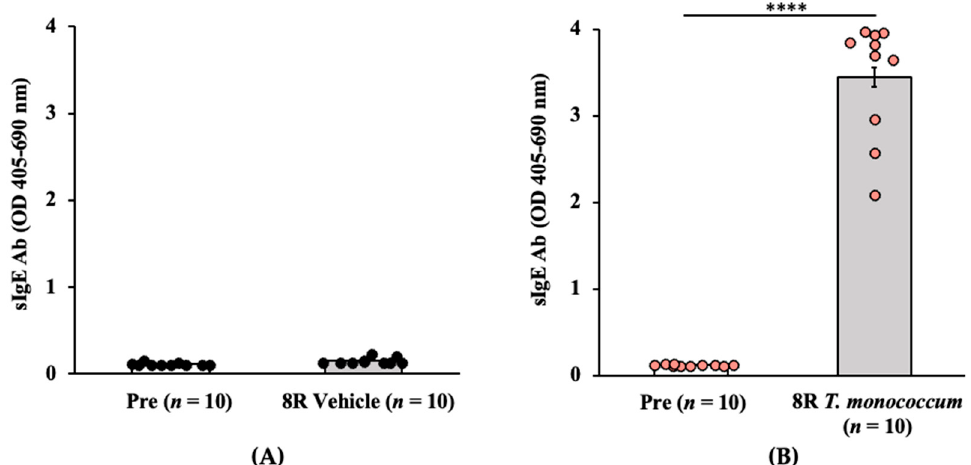
Figure 1. Transdermal exposure of Balb/c mice to SSPE from Triticum monococcum (genome AA) elicited robust specific (s) IgE antibody responses. Mice were exposed to T. monococcum SSPE or saline as described in Methods. Plasma collected before the 1st exposure (Pre) and after the 8th exposure (8R) was used in the measurement of sIgE levels (OD 405–690 nm). ( A ) sIgE levels in control mice. ( B ) sIgE levels in sensitized mice. **** p < 0.001, student’s t -test. Ab: antibody; n : number of mice; SSPE: salt-soluble protein extract; OD: optical density.